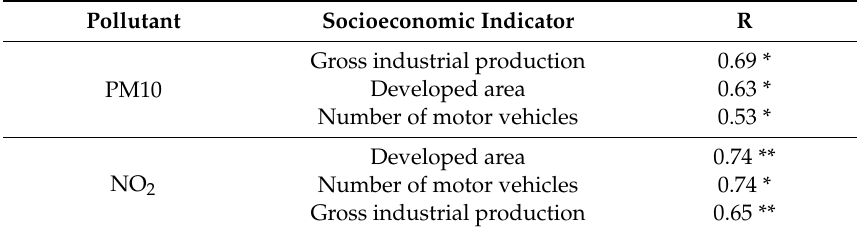
Table 4. Correlation between health e ff ect by ambient pollutants and socioeconomic